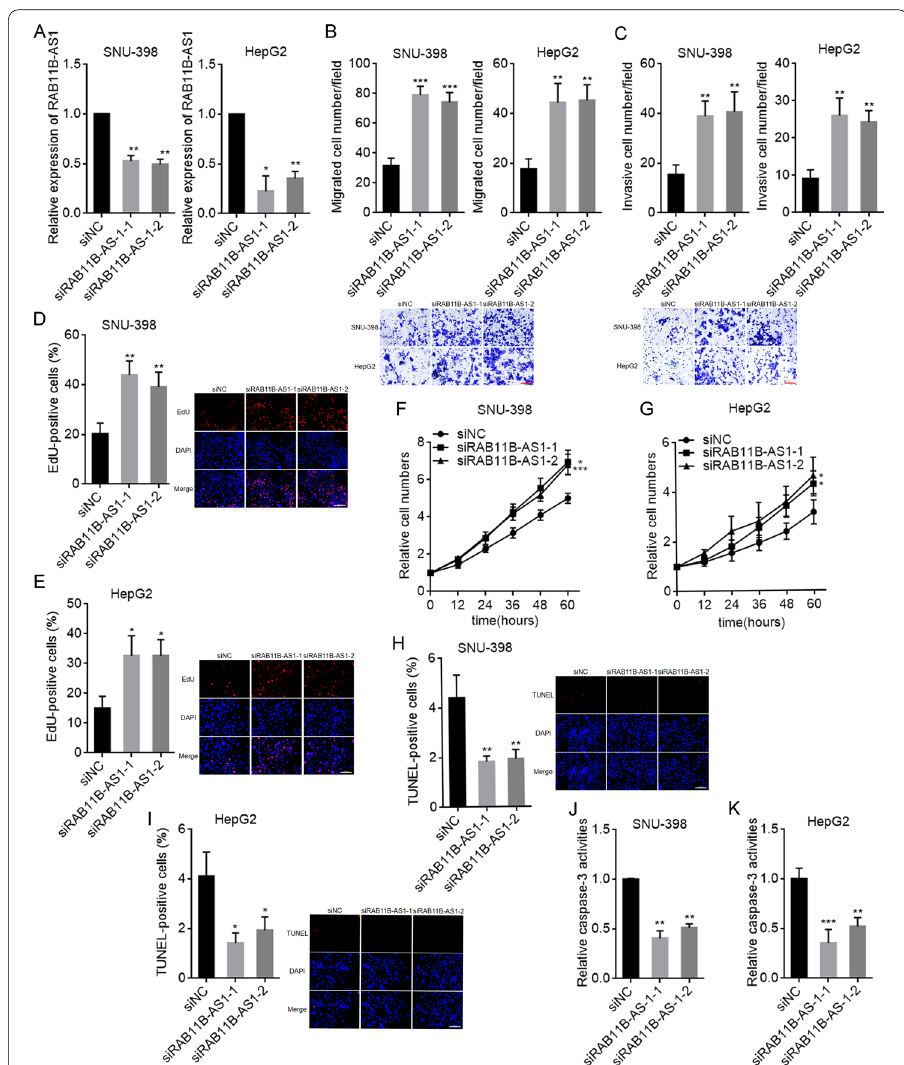
Fig. 7 The roles of RAB11B‑AS1 knockdown in HCC. A RAB11B‑AS1 expression in SNU‑398 and HepG2 cells with RAB11B‑AS1 knockdown or control was detected by RT‑qPCR. B Migration ability of SNU‑398 and HepG2 cells with RAB11B‑AS1 knockdown or control was detected by transwell migration assay. Scale bars, 100 µm. C Invasion ability of SNU‑398 and HepG2 cells with RAB11B‑AS1 knockdown or control was detected by transwell invasion assay. Scale bars, 100 µm. D Cellular proliferation of SNU‑398 cells with RAB11B‑AS1 knockdown or control was detected by EdU assay. Scale bars, 100 µm. E Cellular proliferation of HepG2 cells with RAB11B‑AS1 knockdown or control was detected by EdU assay. Scale bars, 100 µm. F Cellular proliferation of SNU‑398 cells with RAB11B‑AS1 knockdown or control was detected by CCK‑8 assay. G Cellular proliferation of HepG2 cells with RAB11B‑AS1 knockdown or control was detected by CCK‑8 assay. H Cellular apoptosis of SNU‑398 cells with RAB11B‑AS1 knockdown or control was detected by TUNEL assay. Scale bars, 100 µm. I Cellular apoptosis of HepG2 cells with RAB11B‑AS1 knockdown or control was detected by TUNEL assay. Scale bars, 100 µm. J Cellular apoptosis of SNU‑398 cells with RAB11B‑AS1 knockdown or control was detected by caspase‑3 activity assay. K Cellular apoptosis of HepG2 cells with RAB11B‑AS1 knockdown or control was detected by caspase‑3 activity assay. Results are shown as mean independent experiments. * P < 0.05, ** P < 0.01, *** P < 0.001 by one‑way ANOVA followed by Dunnett’s multiple comparisons